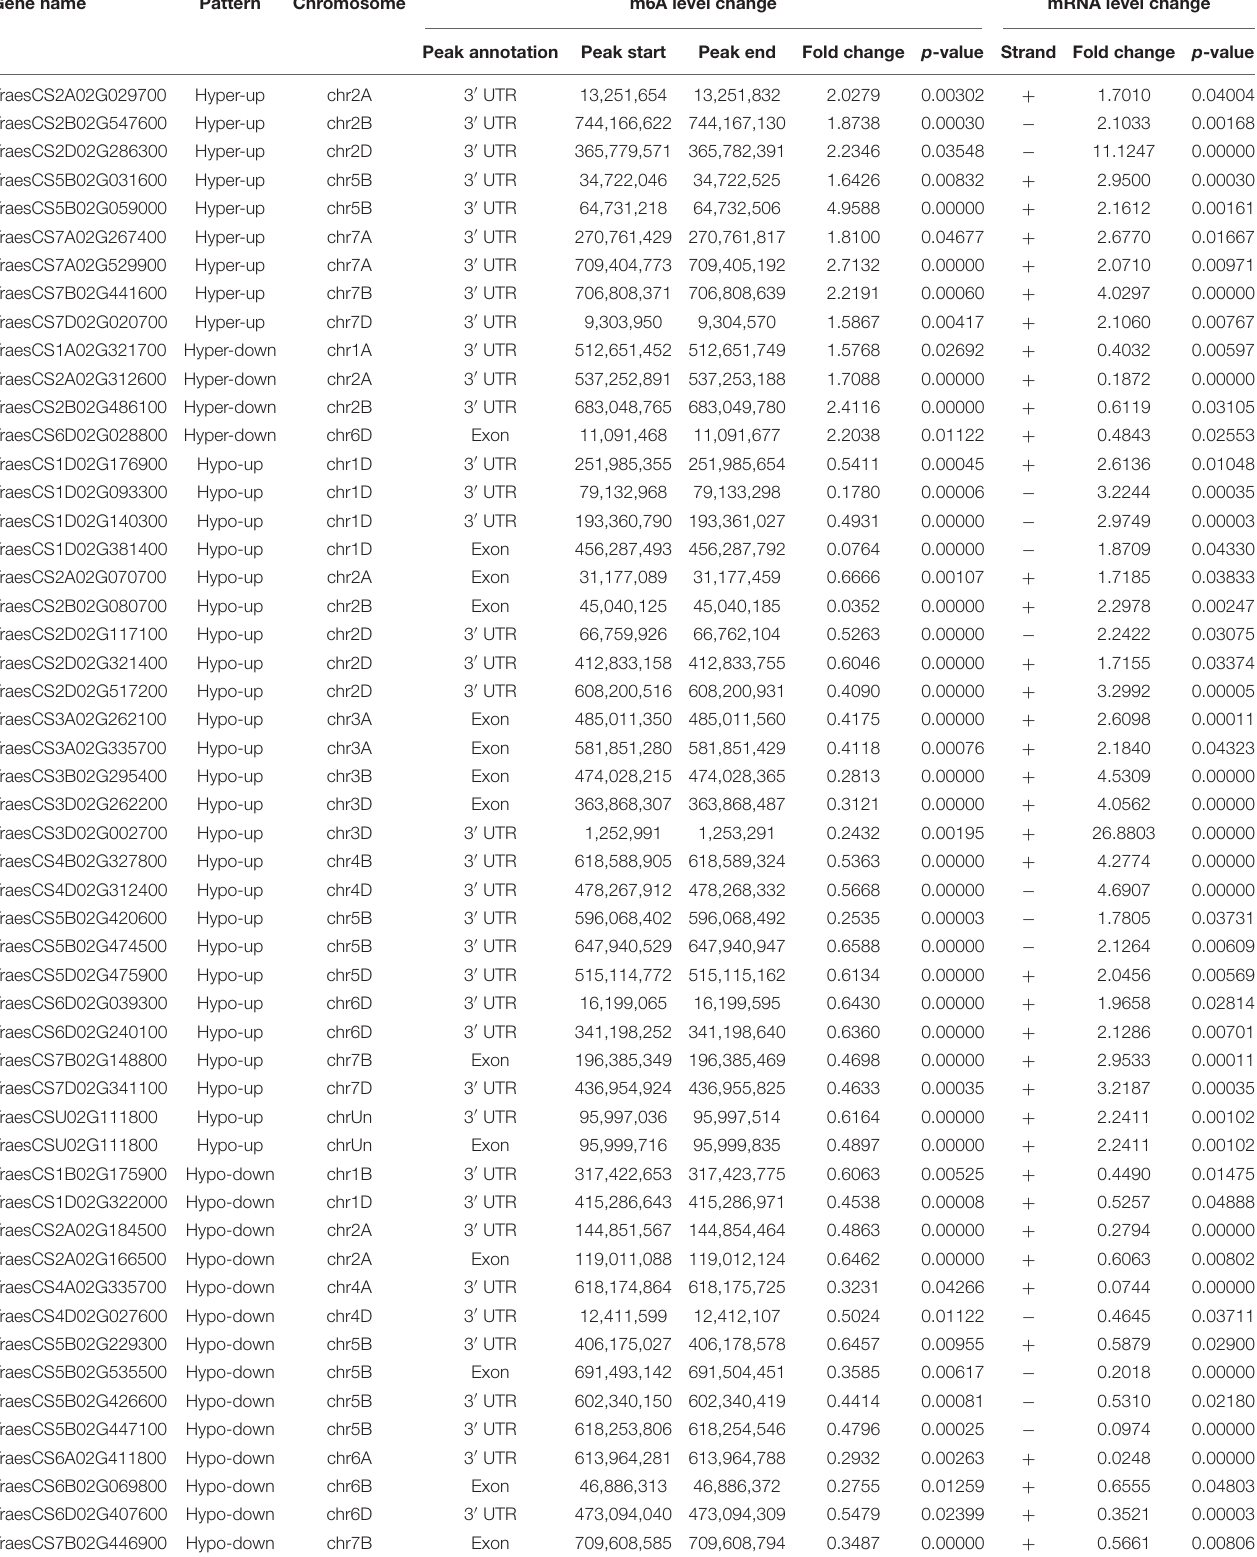
TABLE 1 | List of 52 genes that exhibit a significant change in both m6A level and mRNA transcript abundance in WRV compared with